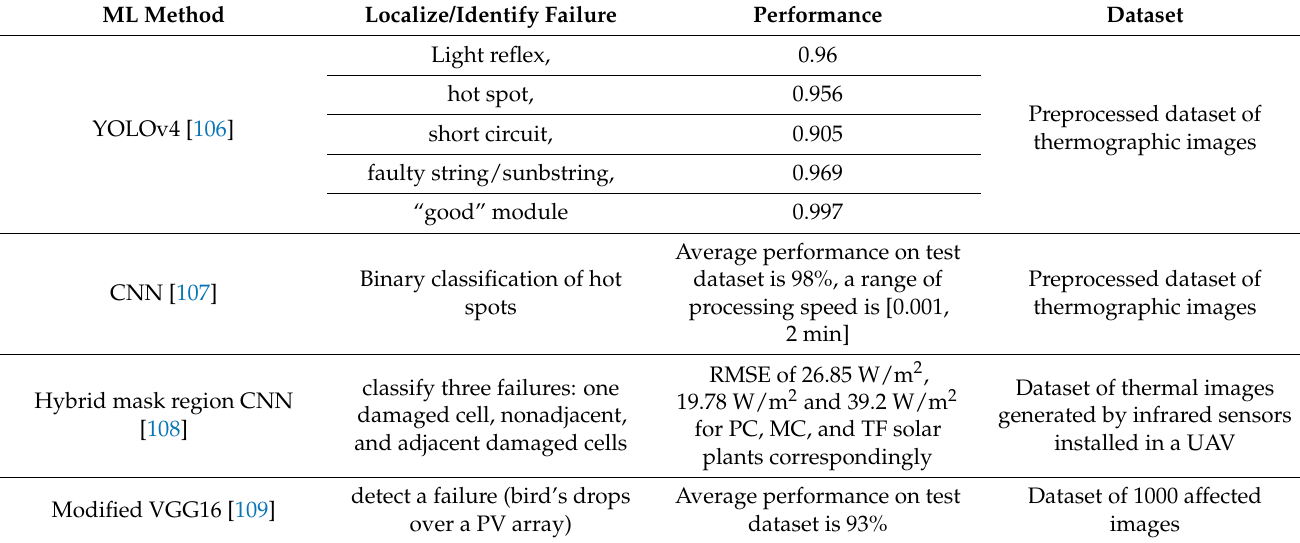
Table 10. Comparison of ML Technologies for PV